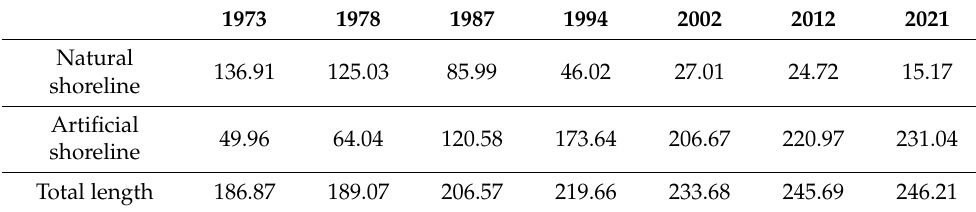
Table 4. Statistics of different mainland shoreline types in Pearl River Estuary (unit: km).